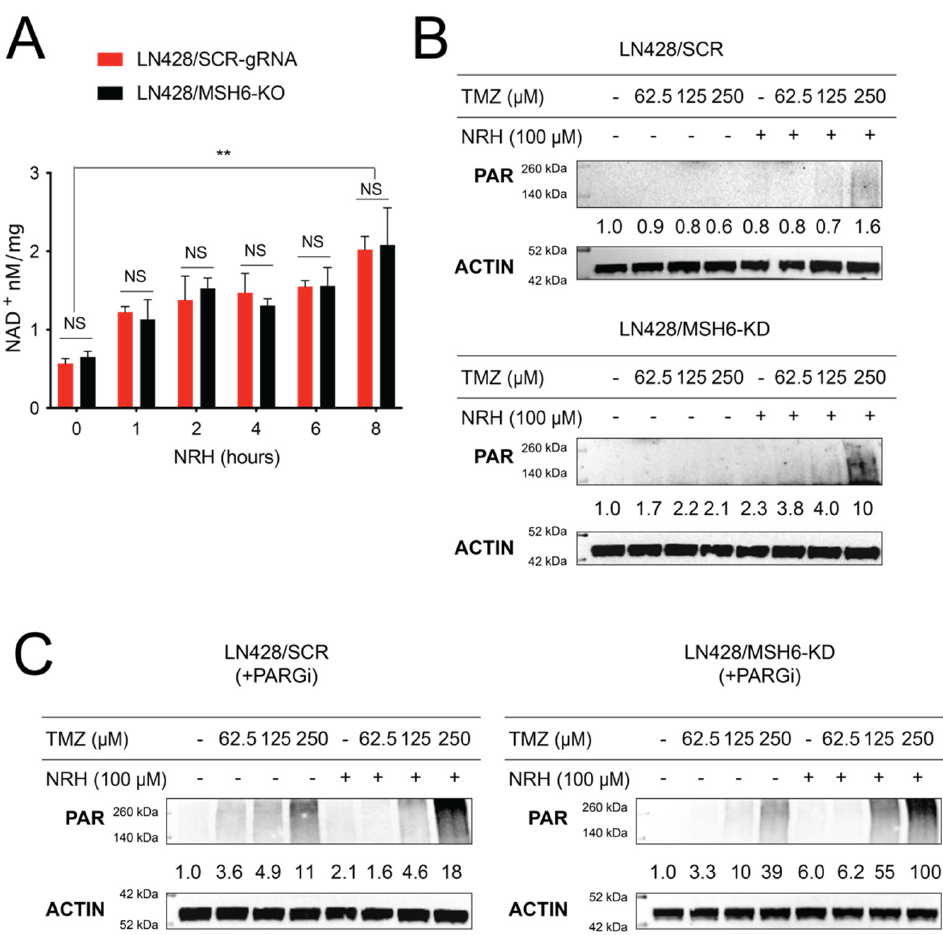
Figure 2. NRH treatment increased cellular NAD + levels and promoted PARP1 activity upon TMZ treatment. ( A ) Total cellular NAD + levels in LN428/SCR-gRNA or LN428/MSH6-KO cells after treatment with NRH (100 µ M) for the time periods indicated; (** p < 0.01, one-way ANOVA; NS = not significant). ( B ) PAR (poly-ADP-ribose) immunoblot analysis of total cell lysates (LN428/SCR cells, top panel; LN428/MSH6-KD, bottom panel) after treatment with NRH (100 µ M) for 4 h and then TMZ at the indicated doses for an additional 1 h, as compared to cells treated with DMSO. β -Actin was used as the loading control. ( C ) PAR (poly-ADP-ribose) immunoblot analysis of total cell lysates (LN428/SCR cells, left panel; LN428/MSH6-KD, right panel) after treatment with PARGi (100 μ M) or N + P for 4 h and then TMZ at the indicated doses for an additional 1 h, as compared to cells treated with PARGi. β -Actin was used as the loading control.